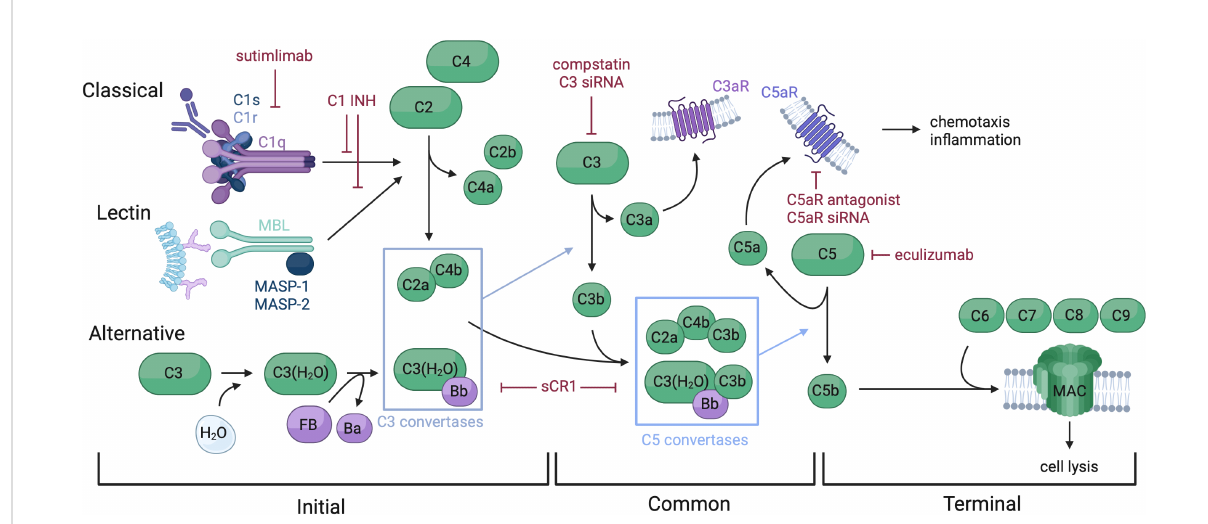
FIGURE 1 Overview of the complement system and therapeutic targets. The complement system is comprised of soluble, membrane bound, and regulatory proteins, and may be activated via three distinct pathways: classical, lectin, and alternative. These pathways converge on the common pathway with the formation of a C3 convertase which splits C3 into C3a and C3b. C3b complexes to the C3 convertases to form a C5 convertase, which splits C5 and triggers assembly of the MAC, making up the terminal pathway. Complement functions include cell lysis via MAC insertion into cell membranes and chemotaxis and in fl ammation regulated by split proteins C3a and C5a. Therapeutics targeting several complement components have been developed, including C1 INH which inactivates C1s, C1r and MASP-1 and -2, thus preventing spontaneous activation of the classical and lectin pathways. Sutimlimab is an anti-C1s mAb approved for cold agglutinin disease. sCR1, and versions of this molecule such as mirococept inhibit C3 and C5 convertases, among other functions. Multiple C3 targeting therapeutics have been developed, such as compstatin and C3 siRNA. C5 and C5aR have been targeted by drugs such as eculizumab (anti-C5 mAb), C5aR antagonist, and C5aR